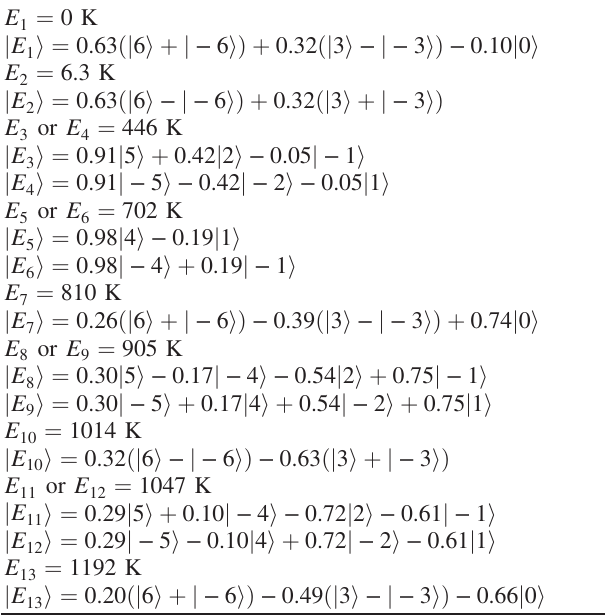
FIG. 10. Temperature dependence of the calculated CEF thermodynamic properties. The least- R fitted average CEF P parameters of TmMgGaO 4 are used, without any CEF random- ness (broadening) and without any intersite magnetic couplings. The dashed blue lines show the Curie fits to the calculated ∼ 1 =T ), at 30 ≤ T ≤ 60 K and susceptibility along the c axis ( χ k T > 4000 K, respectively. The entropy (black) and dc suscep- tibilities (red) are calculated at 0 and 0.05 T (measuring field), respectively.